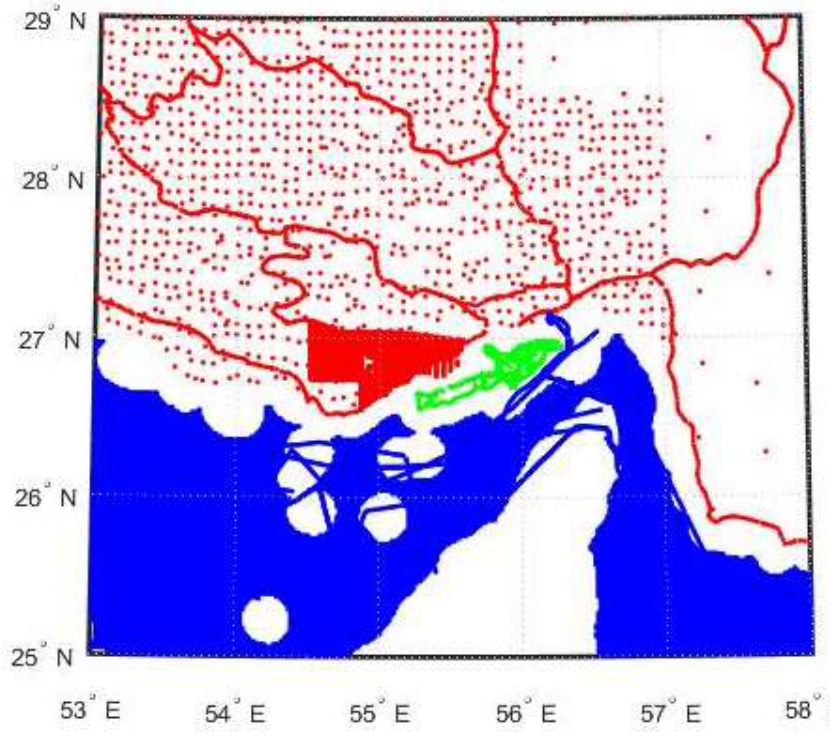
Figure 2. The spatial distribution of gravity data: terrestrial data used in [27] ( green ), newly added terrestrial ( red ) and marine gravity anomalies from re-tracked altimetry ( blue ).